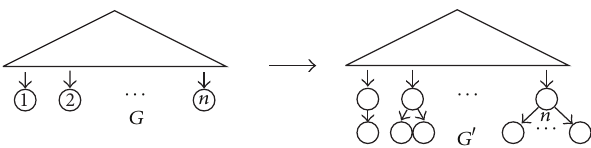
Figure 1: The construction involved in the reduction of the isomorphism of 𝑆 -rDAGs to the isomorphism of rDAGs.